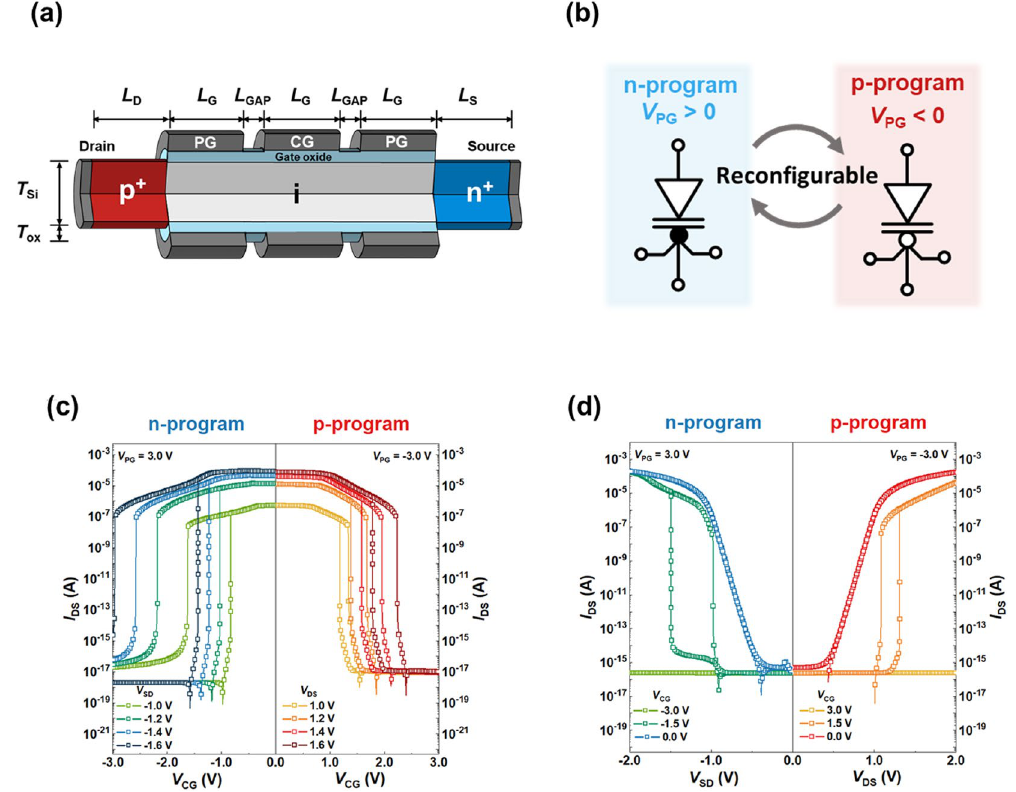
Figure 1. Design and electrical characteristics of triple-gate feedback random access memory (FBRAM) ( a ) Schematic of triple-gate FBRAM. ( b ) Circuit symbols of triple-gate FBRAM when operating in n- and p-program modes. ( c ) Transfer characteristics of triple-gate FBRAM in n- and p-program modes under several supply voltages. ( d ) Output characteristics of triple-gate FBRAM in n- and p-program modes under various V CG